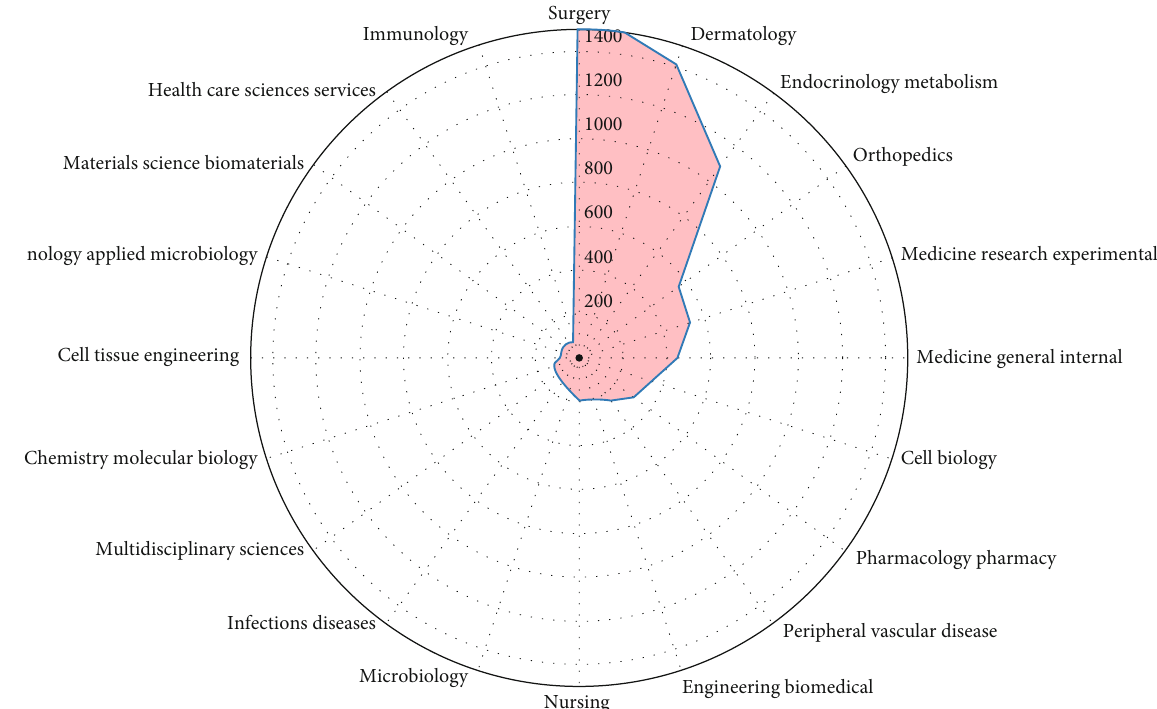
Figure 5: Radar map of the top 20 research productive categories. Note: the radar map was drawn by a bioinformatics online tool (http://www.bioinformatics.com.cn/).